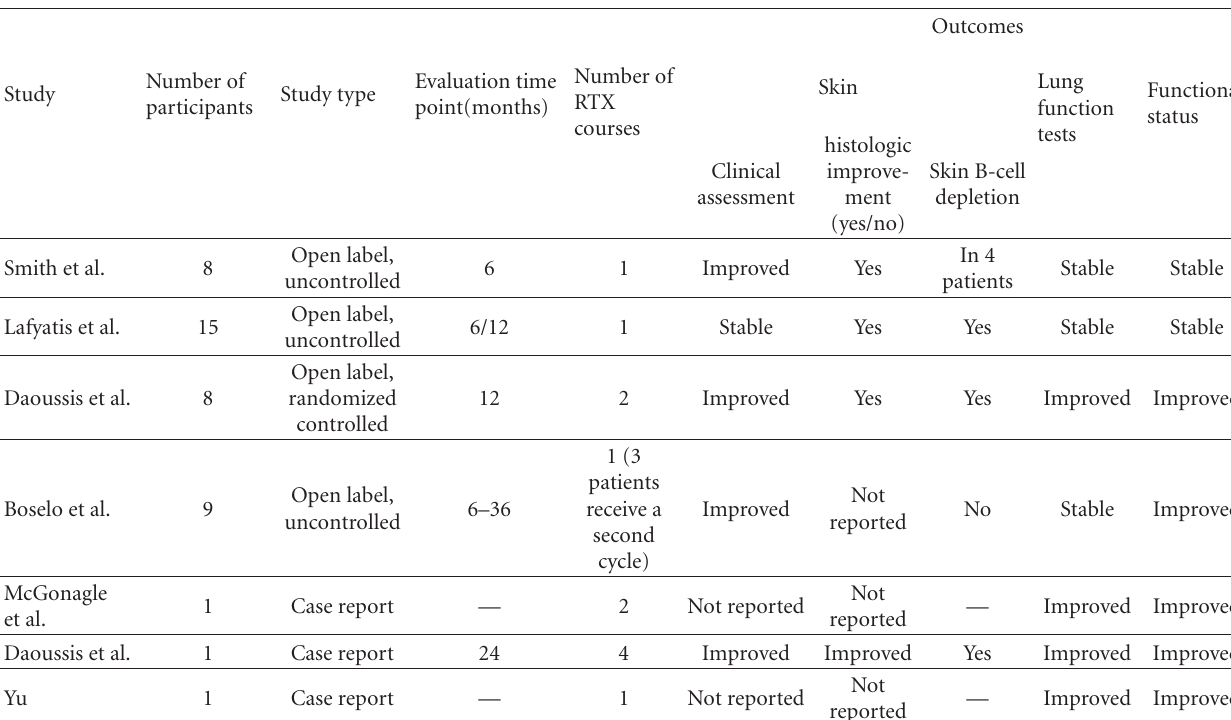
Table 1: Studies assessing the e ffi cacy of RTX in